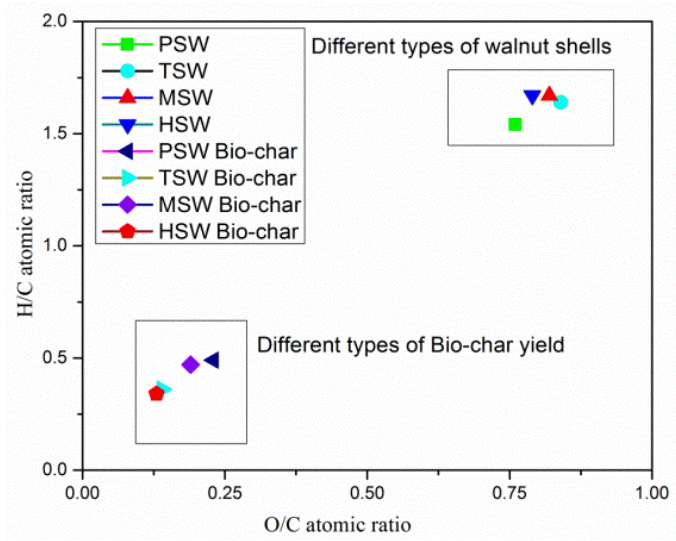
Figure 3. Van Krevelen diagram of different types of walnut shells and their respective bio-char yields.